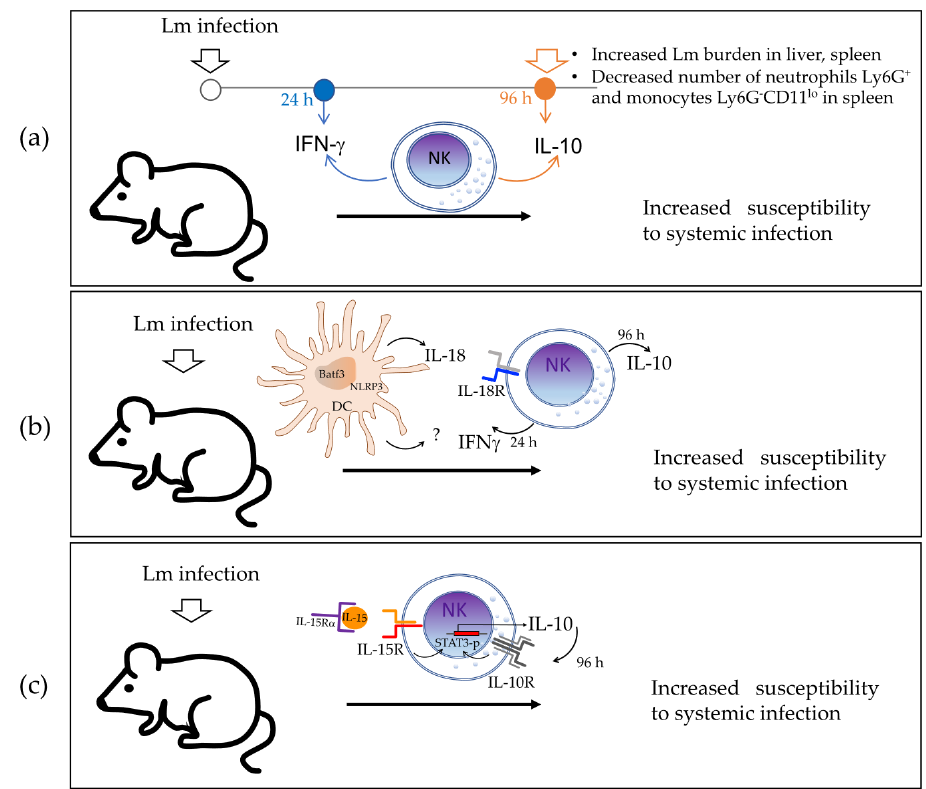
Figure 2. Proposed models of the role of IL-10-producing NK cells in Listeria monocytogenes (Lm) systemic infection in mice. ( a ) In this first study, it was found that NK cells produce pro-inflammatory IFN γ during the early phase of infection (24 h post-infection) but rapidly switch to anti-inflammatory IL-10 production and become the main source of IL-10 (96 h post-infection). IL-10-deficient mice that received NK cells from wild-type mice showed an increased Lm burden in the liver and spleen and a reduced number of neutrophils and monocytes in the spleen compared with those receiving IL-10-deficient NK cells, suggesting that IL-10 produced by NK cells increases susceptibility to systemic bacterium infection. ( b ) In this study, the kinetic of IFN γ and IL-10 production by NK cells during Lm systemic infection was confirmed. In addition, IL-18 produced by DCs expressing NLRP3 and Batf3 is required but is not sufficient to induce IL-10 production by NK cells in infected mice. ( c ) In this study, it was discovered that IL-15 signaling induces early STAT3 activation in NK cells required for the IL-10 production response to Lm infection. This, in turn, feeds back through IL-10R in NK cells to promote sustained STAT3 activation and IL-10 production by NK cells observed at 96 h post-infection, which is associated with increased susceptibility to Lm systemic